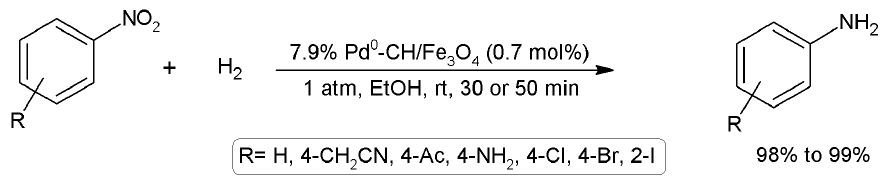
Figure 25. Hydrogenation of nitroarenes using chitosan-based catalysts loaded with Pd 0 .